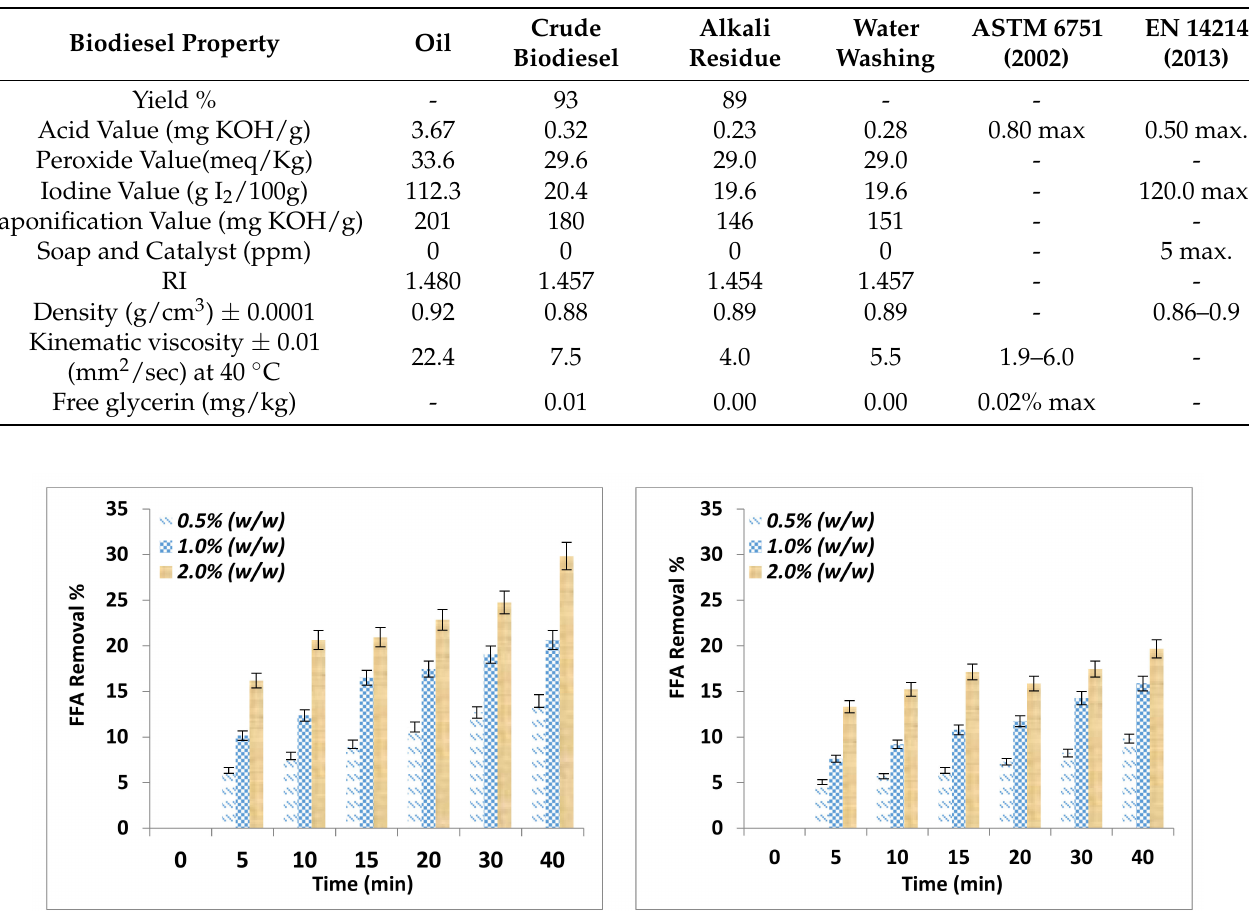
Table 2. Waste vegetable oil, crude biodiesel, alkali residue, and water washing purified biodiesel.